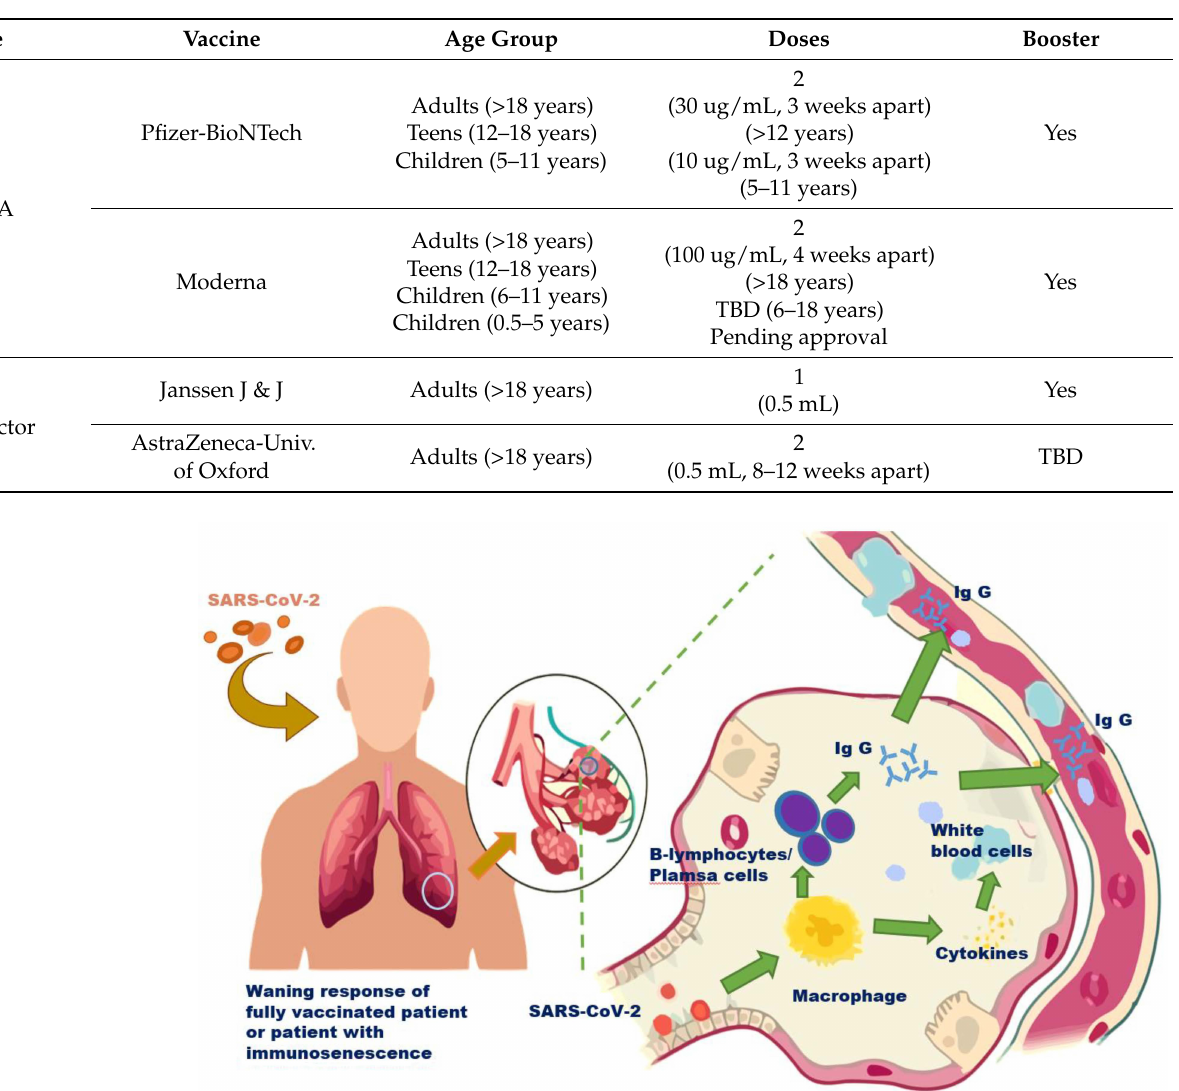
Table 1. Major SAR-CoV-2 vaccines available (updated April 2022).